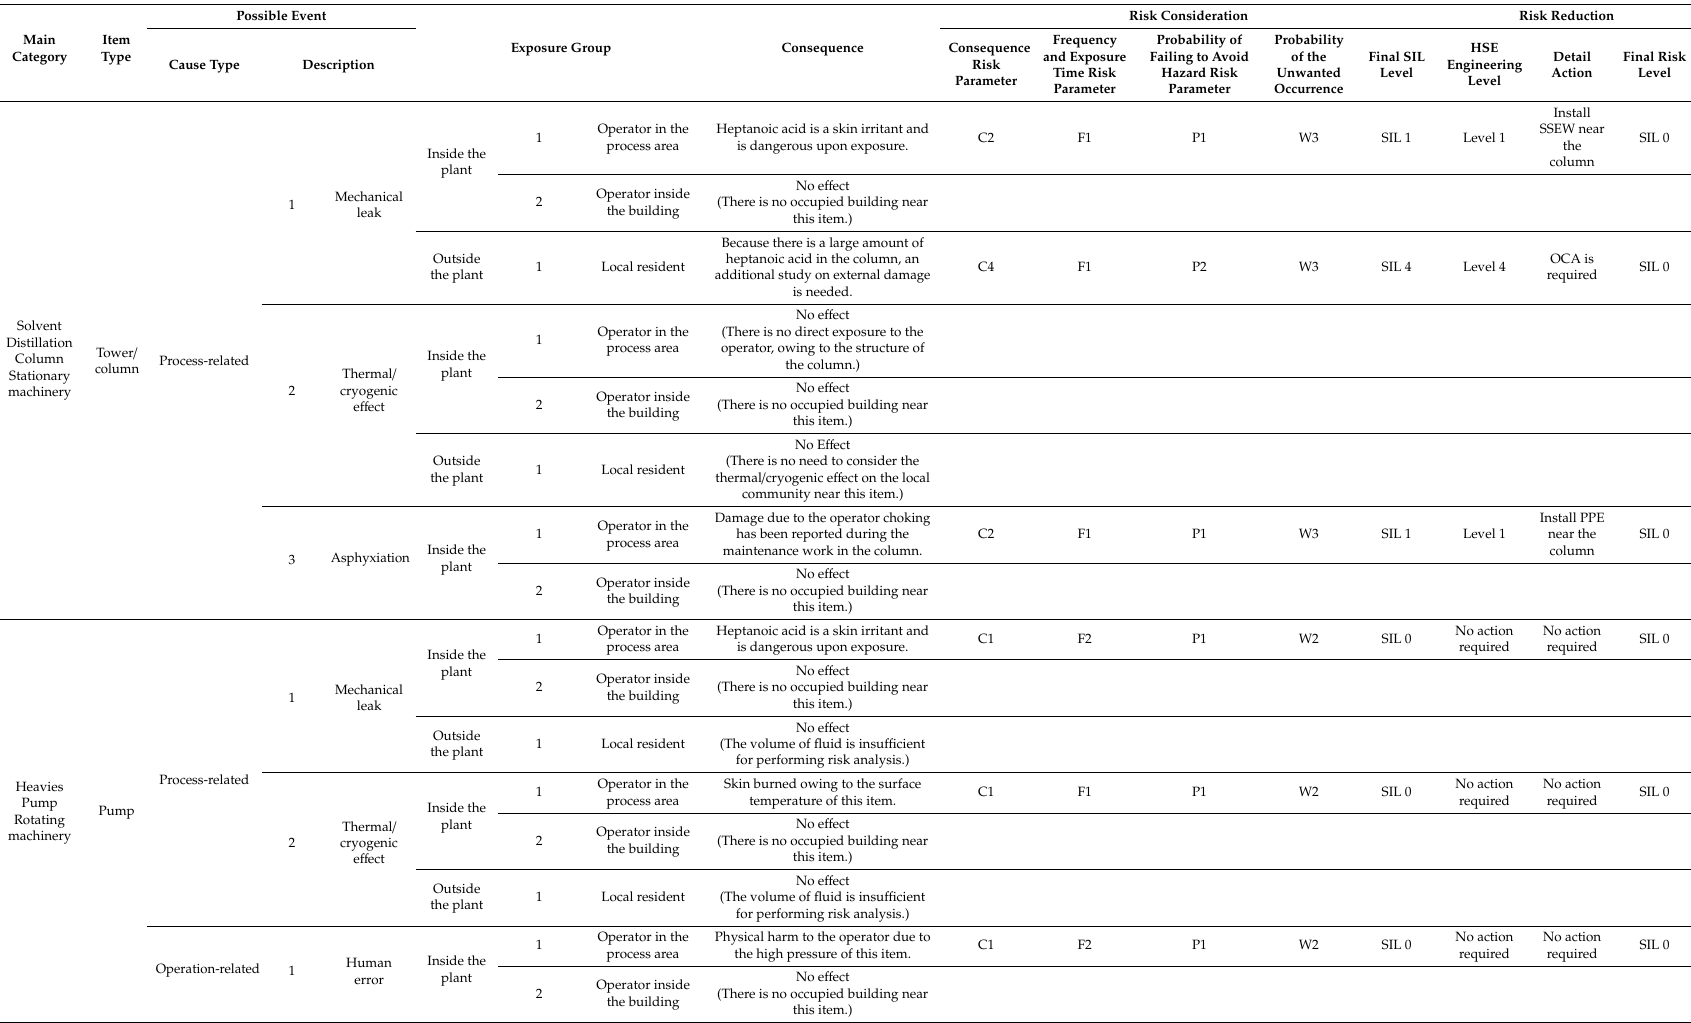
Table 15. SSBR Plant HSE-HAZOP Worksheet